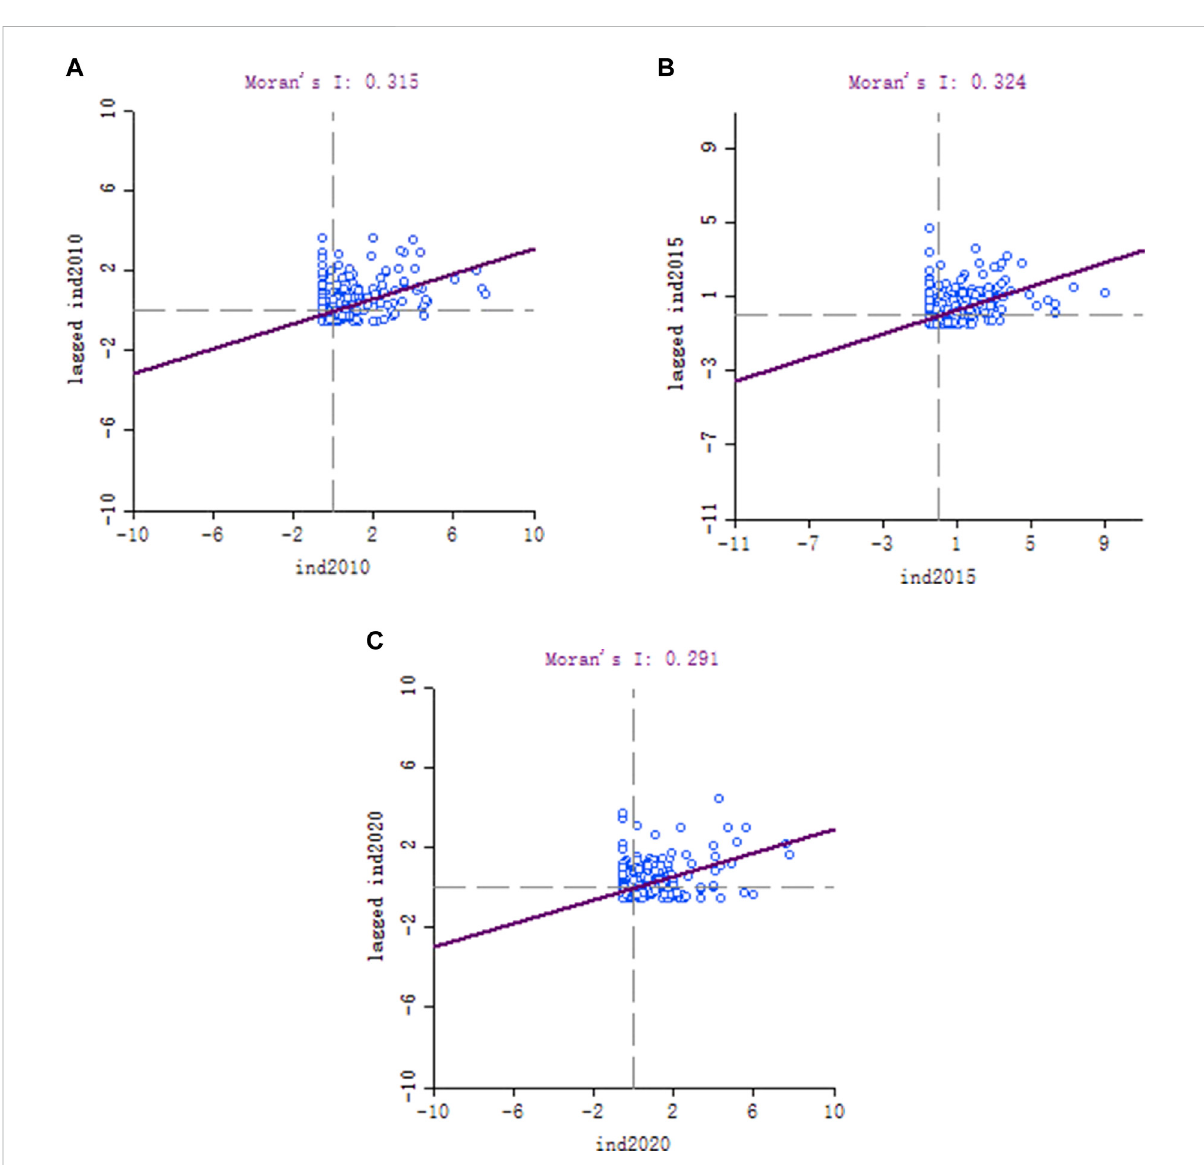
FIGURE 4 Moran scatter plot of industrial agglomeration in the YRB in 2010 (A) , 2015 (B) , and 2020 (C)